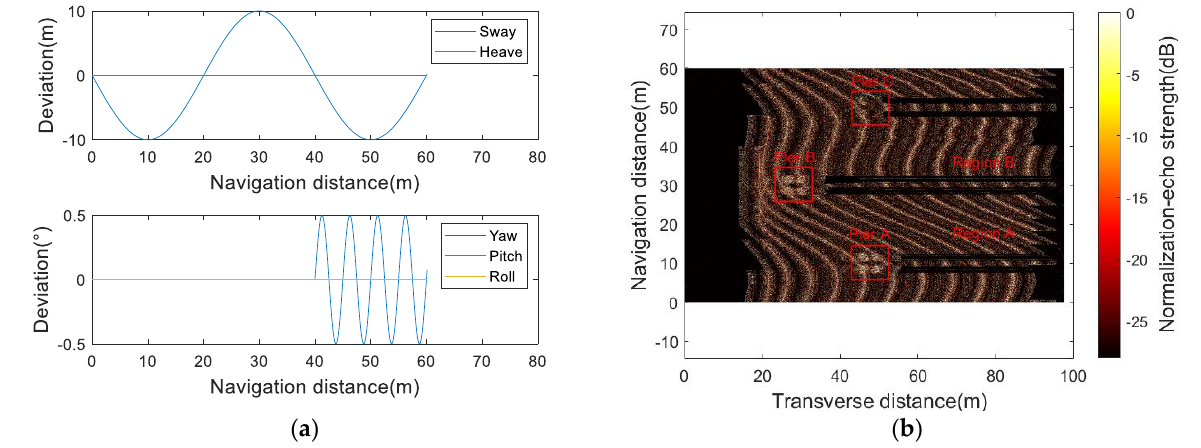
Figure 18. ( a ) Artificially modulated motion deviation curve; ( b ) simulation imaging result.